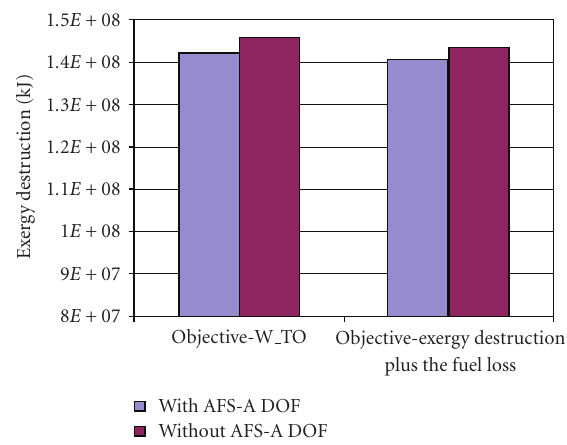
Figure 1: E ff ect of optimization metric on generic high-speed fighter as exergy destruction. Minimizing exergy destruction directly gives the same overall performance as minimizing take-o ff weight; the advantage with exergy destruction is to identify areas for improvement.